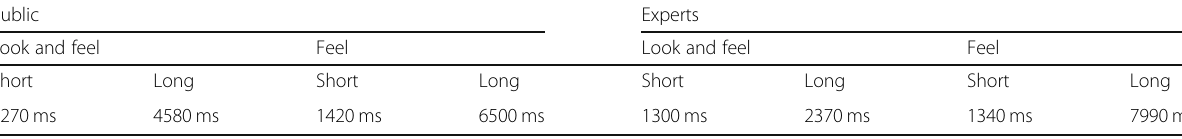
Table 3 Average handling time per